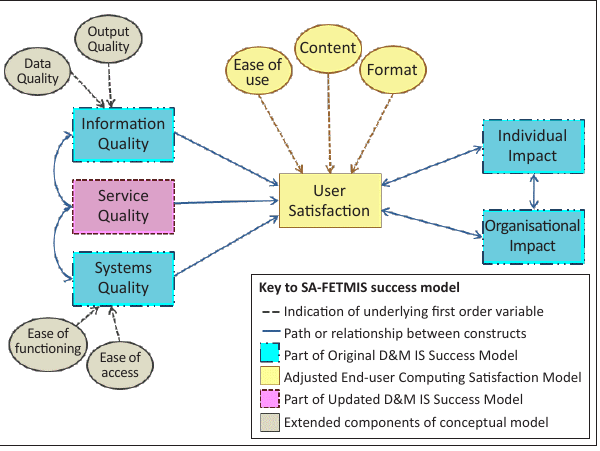
FIGURE 5: Conceptual model for evaluation of management information systems performance at public Further Education and Training College X – The SA-FETMIS success model.